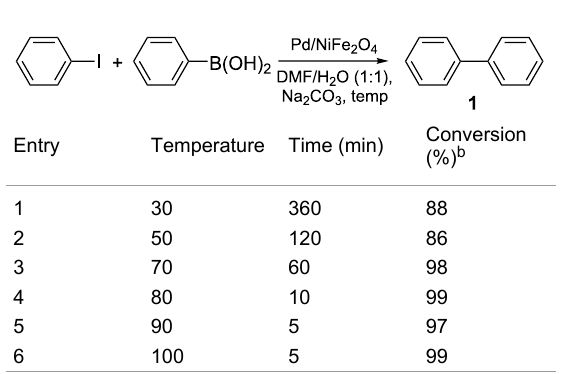
Table 3: The effect of various temperatures on the Suzuki coupling reaction a